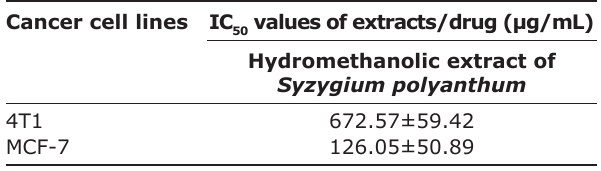
values ( µ g/mL) of Syzygium polyanthum Table-6: IC 50 extract on 4T1 and MCF-7 mammary carcinoma cell lines. Cancer cell lines IC values of extracts/drug (µg/mL) 50